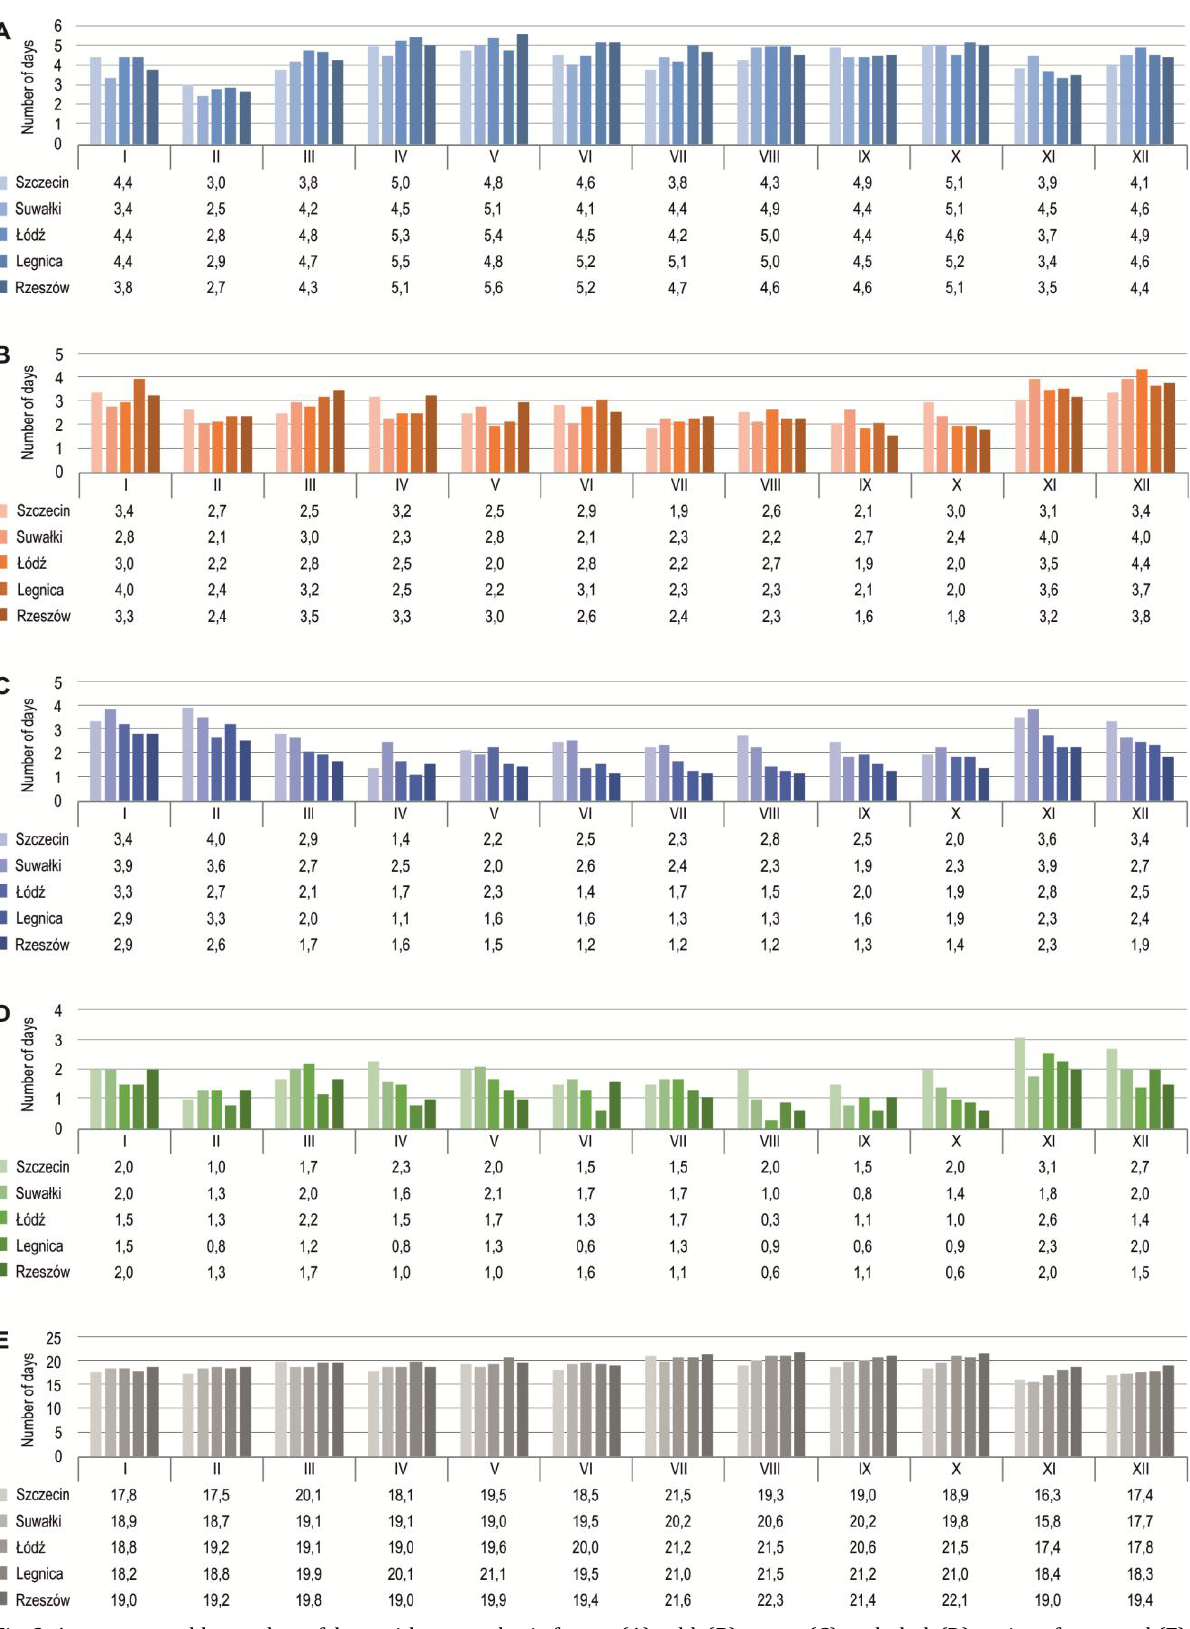
Fig. 3. Average monthly number of days with atmospheric fronts: (A) cold, (B) warm, (C) occluded, (D) various fronts and (E) days without fronts at selected stations in the period